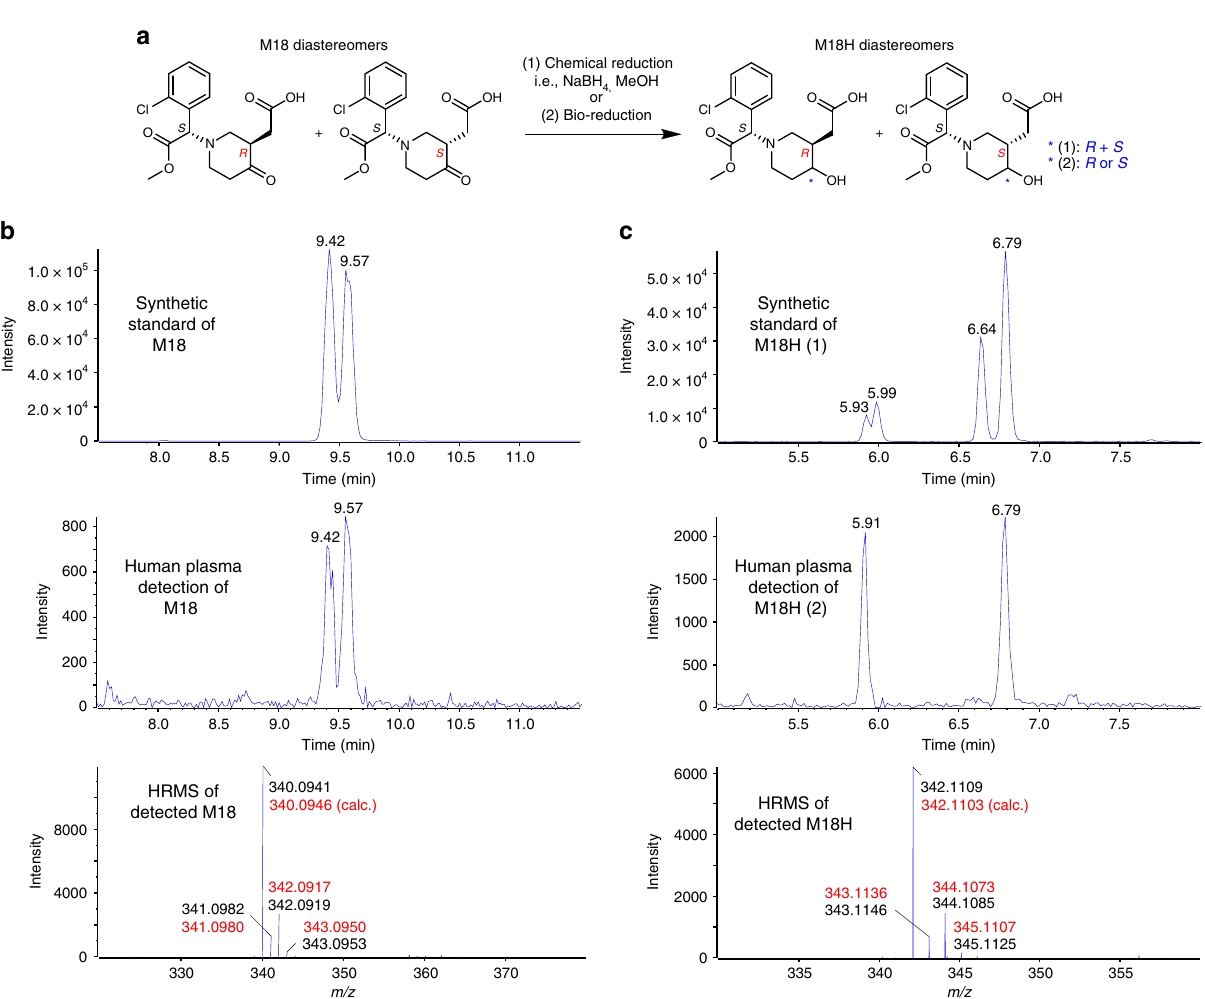
Fig. 4 Detection of H 2 S-released metabolites of CPG in healthy volunteers after an oral dose. a Structures of M18 and M18H diastereomers. Detection of b M18 and c M18H in pooled human plasma samples ( t = 1 h, n = 6) by